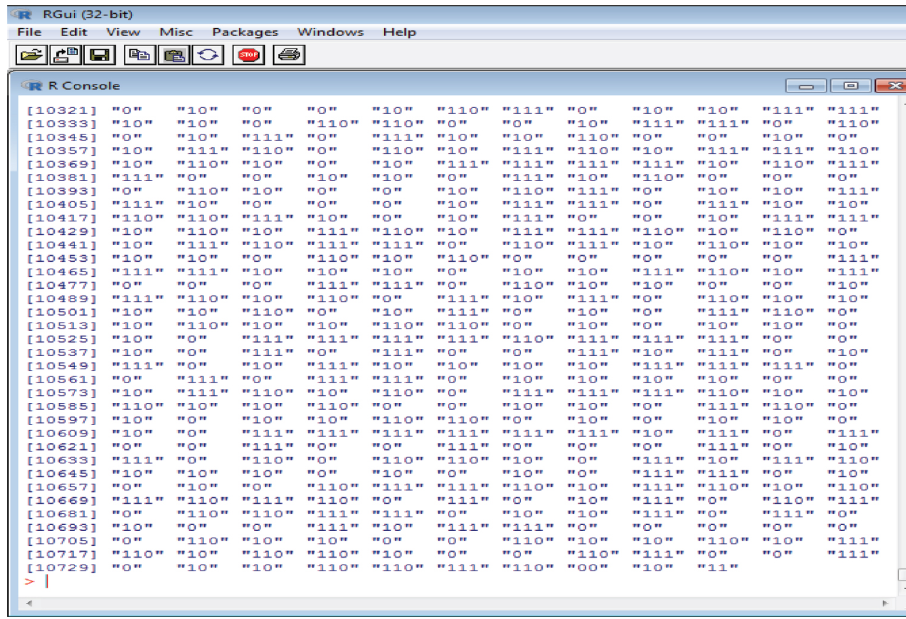
Figure 7: Bottom of the compressed